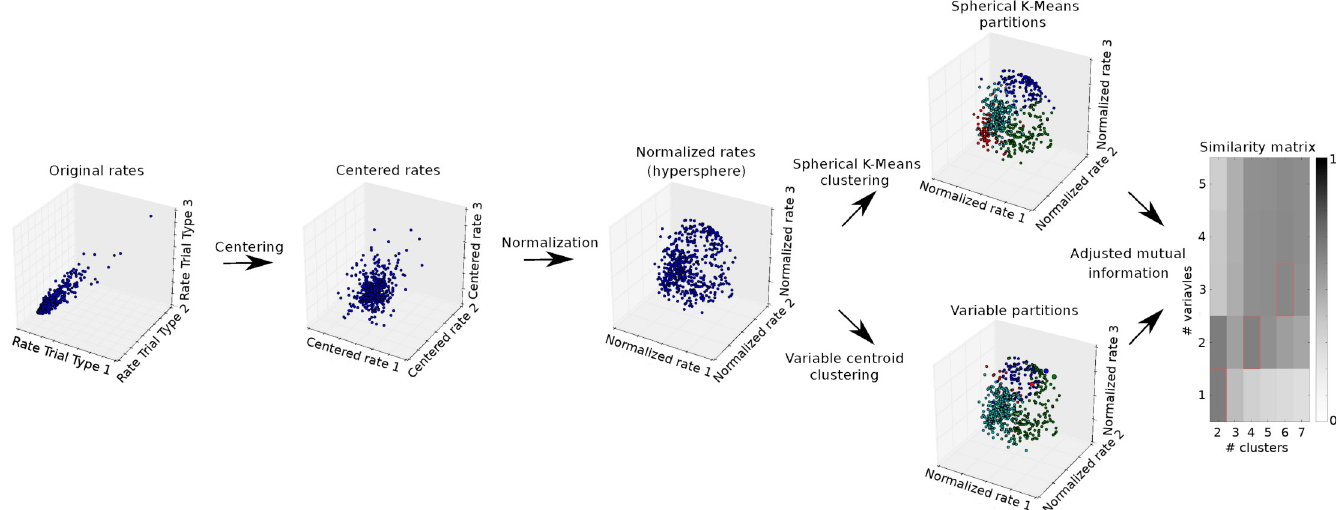
Fig 2. Illustration of the procedure for category discovery. For the original rates (left), each axis of the space denotes the firing rate of the cells in the various trial types. Each data point in this space represents a cell. For illustration, we present only 3 of the 9 dimensions. The original rates are then centered and normalized to unit length. The normalization effectively moves the points to the surface of a hyper-sphere. The points are then clustered using spherical k-means for a given number of clusters and centroid clustering for given variables. In the illustration, variables are represented as larger points. The resulting partitions are compared using the adjusted mutual information measure as a function of the number of clusters and number of variables